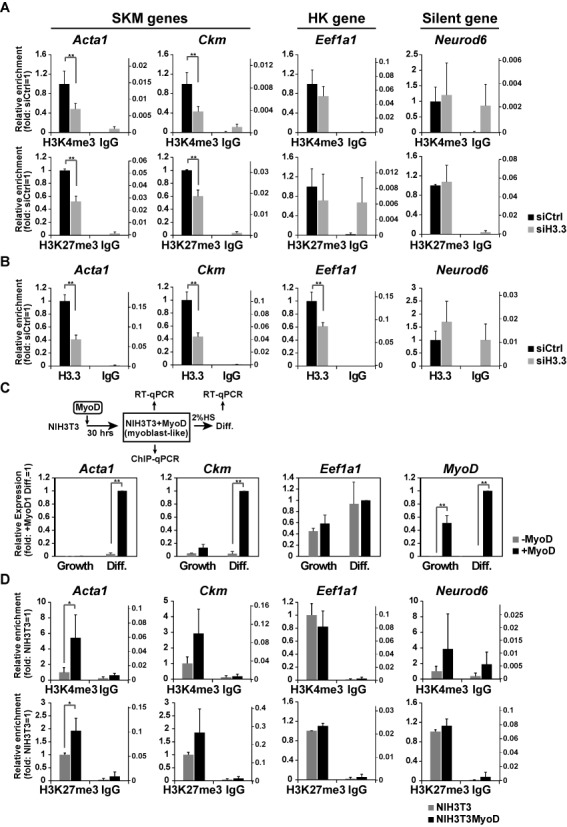
Bivalent modifications at SKM-gene regulatory sequences are dependent on H3.3. ChIP-qPCR assays were performed as in Figure3A. (A and B) H3K4me3 enrichment (A, upper panels), H3K27me3 enrichment (A, bottom panels), and H3.3 (B) were analyzed using C2C12 cells treated with either control siRNA or H3.3 siRNA. Recovery efficiency (mean ± standard deviation of three independent experiments) is expressed as relative enrichment to WT cells (left axis) and ratio to input (right axis). *P < 0.05, **P < 0.01. (C and D) Effects of MyoD-induced H3.3 incorporation into SKM genes on mRNA expression and histone modifications. The experimental scheme is illustrated (C, top). (C) mRNA levels analyzed by qPCR. Relative values to differentiated cells expressing NIH3T3+MyoD are shown (mean ± standard deviation of three independent experiments). (D) ChIP assays. Recovery efficiency (mean ± standard deviation of three independent experiments) is expressed as relative enrichment to WT cells (left axis) and ratio to input (right axis). *P < 0.05, **P < 0.01.